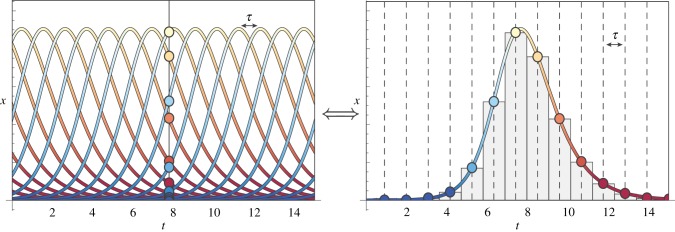
A tiling principle. On the left, An idealized realization of the Red Queen dynamics is depicted, in which new alleles invade the population at regular time intervals, all equal to τ, and have the same allele frequency trajectory. Taking the sum of allele frequencies at any given time (vertical bar), which by definition is equal to 1, is then equivalent to summing the values taken by the frequency of one specific allele at regular time intervals (right). Multiplying this sum by τ amounts to approximating the integral  by the histogram shown on the right panel. Thus, . This argument can more generally be used to approximate any sum of the form  by the corresponding integral . (Online version in colour.)